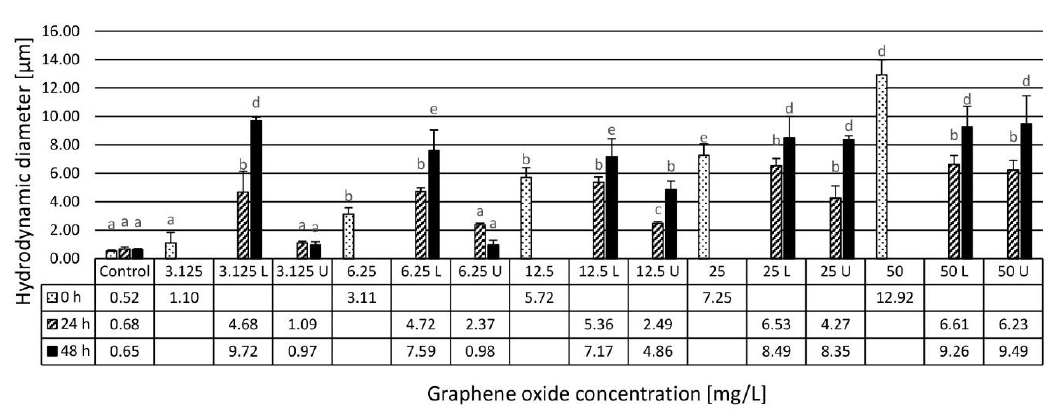
Figure 1. Mean values of hydrodynamic diameter (in nm) of GO particles in the assembled test systems at a zero time point and after 24 and 48 h of exposure reported from n = 3 determinations per sample. U: upper phase, L: lower phase. Letters on the columns indicate significant differences (level of significance: p < 0.05).